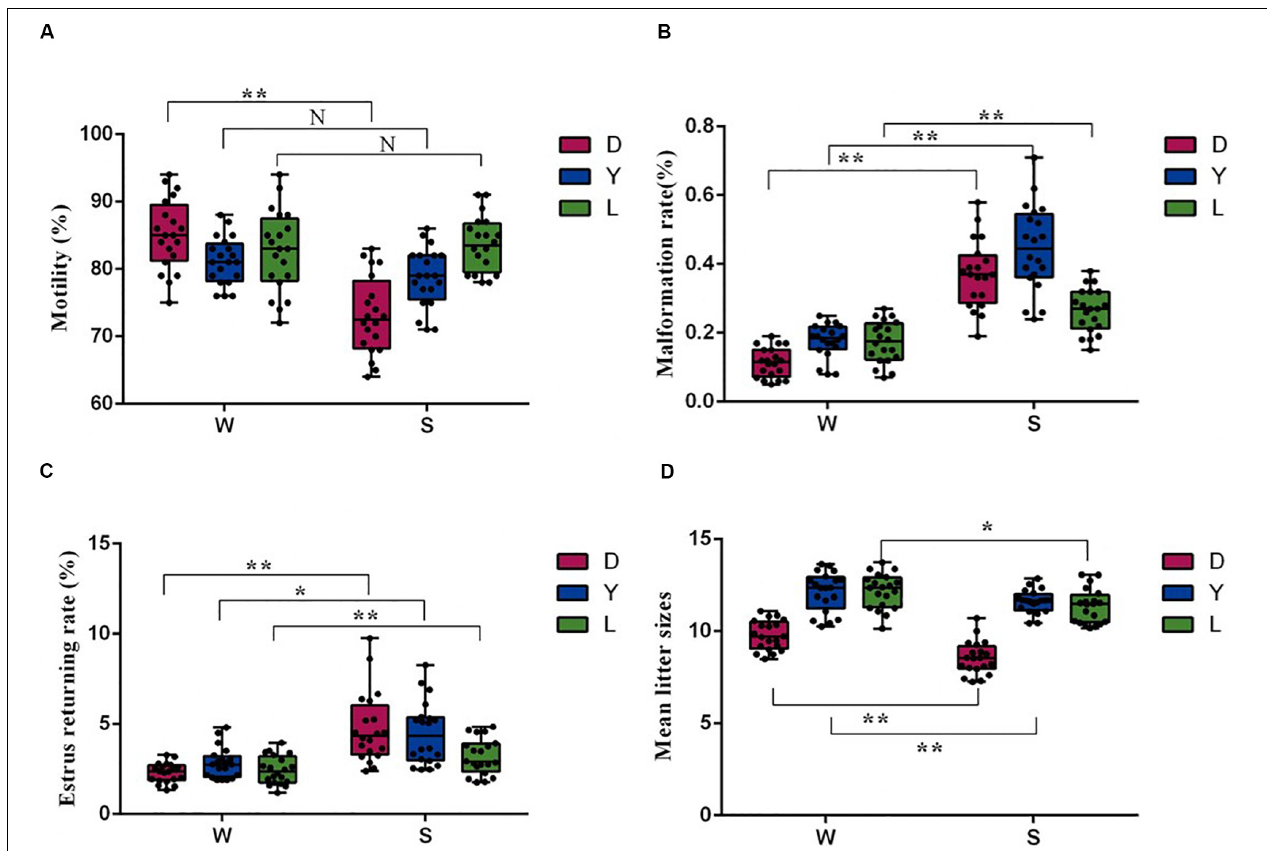
FIGURE 1 | Comparison of sperm quality and reproductive parameters of sows after AI using 60 semen examples in winter (W) and in summer (S), respectively. (A) Sperm motility parameters, (B) Malformation rate, (C) Estrus returning rate (%), and (D) Mean litter size ( n = 20, * P < 0.05, ** P < 0.01). D, Duroc; L, Landrace; Y,